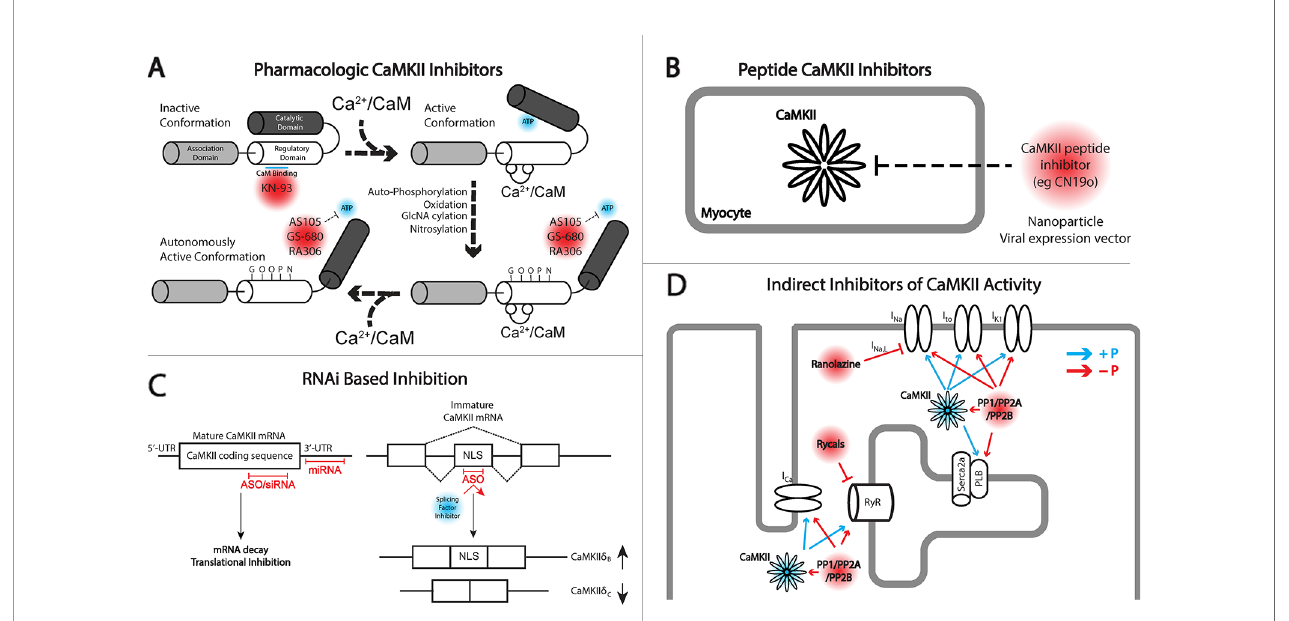
FIGURE 1 | Different approaches for targeting Ca 2+ /calmodulin-dependent protein kinase II (CaMKII) signaling. (A) Depiction of inactive and active monomers of CaMKII showing the association, regulatory, and catalytic domains. The association domain is responsible for interaction with other CaMKII monomers and is necessary for forming the holoenzyme structure, consisting of 12 monomers. In its inactive state, the catalytic domain is obscured by interaction with the regulatory domain. This interaction is disrupted upon the binding of Ca 2+ /CaM leading to autophosphorylation by neighboring CaMKII monomers, in addition to other posttranslational modi fi cations including oxidation, GlcNAcylation, and nitrosylation, maintaining CaMKII activation even upon release of Ca 2+ /CaM. KN-93 is a known allosteric inhibitor of CaM binding and therefore preferentially targets CaMKII in the inactive state. CaMKII inhibitors AS105, GS-680, and RA306 are novel pyrimidine – based, ATP-competitive inhibitors that inhibit the activated catalytic domain of CaMKII and represent potential therapeutic agents for translational CaMKII inhibition. (B) Peptide inhibitors of CaMKII (e.g., CN19o, re fi ned from CaMKIItide) show favorable selectivity and potency for CaMKII inhibition but face challenges in delivery and bioavailability. Both viral gene delivery and novel advances in nanoparticles offer opportunities for delivery of these agents to the heart. (C) RNA interference (RNAi) is a novel approach for inhibiting CaMKII activity at the transcript level. Antisense oligonucleotides (ASOs), small interfering RNA (siRNA), and miRNAs provide opportunity for degrading CaMKII transcripts and/or inhibiting protein translation. ASOs can also be used to interfere with recruitment of splicing factors to enhance concentrations of CaMKII d B which has been shown to have cardioprotective effects. (D) Indirect inhibition of CaMKII can be achieved by regulating downstream targets of CaMKII kinase activity. An example comes from the late Na + current (I Na,L ) inhibitor ranolazine, or the RyR stabilizing agents, rycals. Alternatively, protein phosphatases may be targeted to antagonize kinase activity in cardiomyocytes. The development of phosphatase activators for cancer therapeutics may offer opportunity for drug applications in cardiovascular